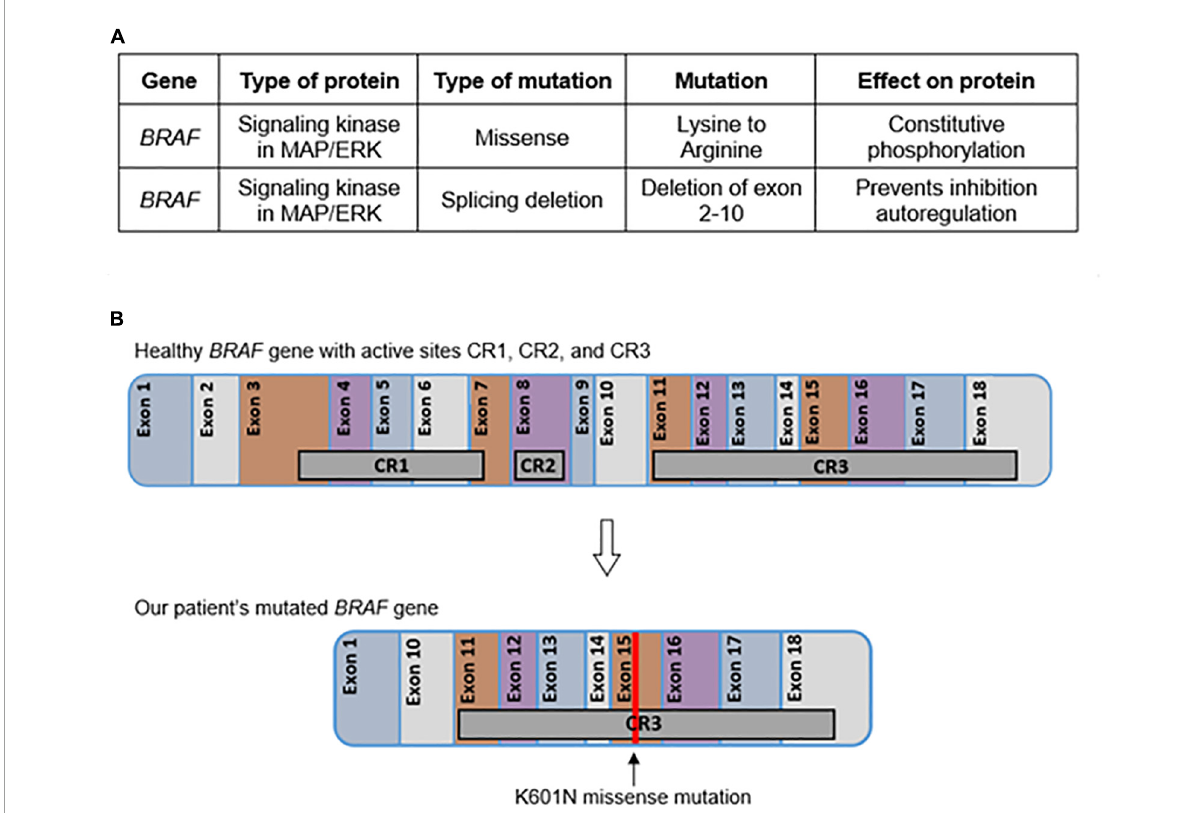
FIGURE4 Tumor genetics. The effects of each mutation determined by the solid tumor comprehensive panel are given in table format (A) . The location of each active site and chromosomal change in BRAF are represented graphically (B)